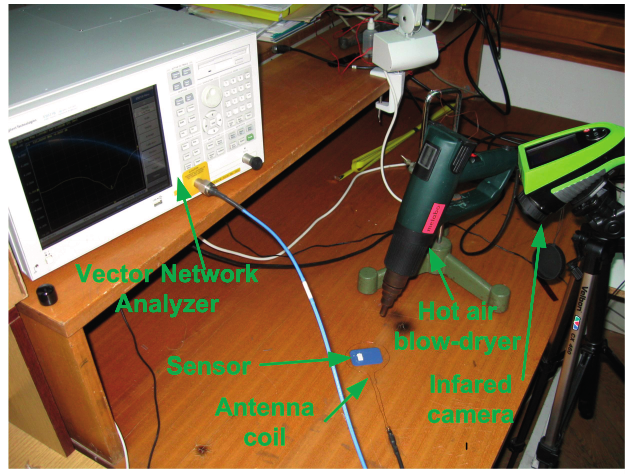
Figure 5. Experimental setup for measuring temperature (sensor, antenna coil, Vector Network Analyzer E5071B, hot air blow-dryer and Infrared Camera).